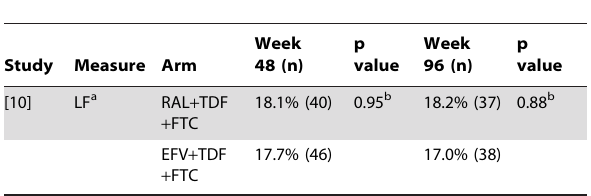
Table 6. Change from baseline in limb fat (LF) on DEXA scan and subcutaneous adipose tissue (SAT) on CT scan: raltegravir versus efavirenz.